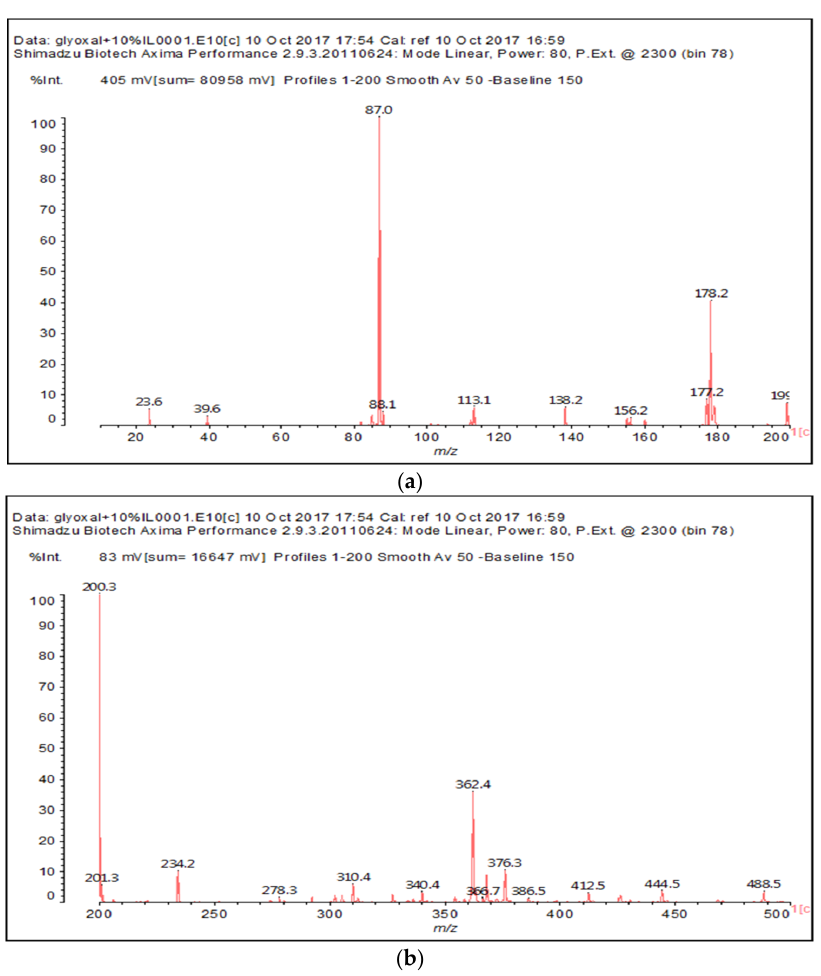
Figure 3. MALDI-ToF spectrum of the interaction between glyoxal and N -methyl-2-pyrrolydone hydrogen sulphate ([HNMP] HSO 4 − ) ionic liquid: ( a ) 20–200 Da range; ( b ) 200–500 Da range.